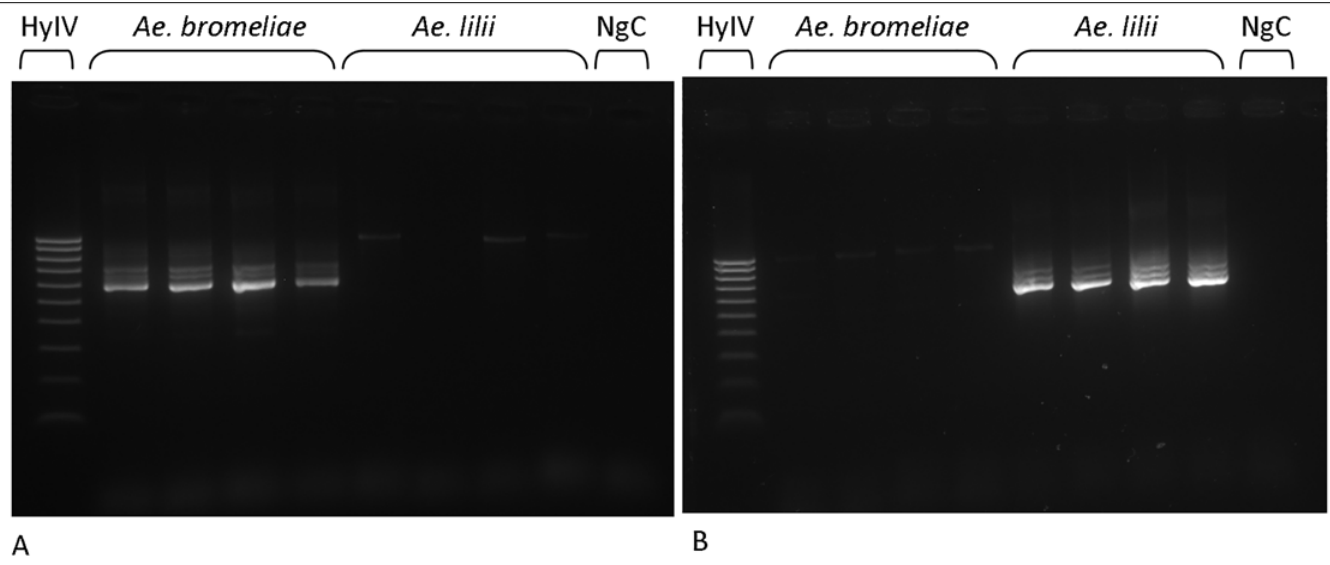
Fig 6. Electrophoresis gel for primer sets (A) BRO-F and BRO-R and (B) LIL-F and LIL-R. PCR products were run with Hyperladder IV (HyIV) and a negative control (NgC).